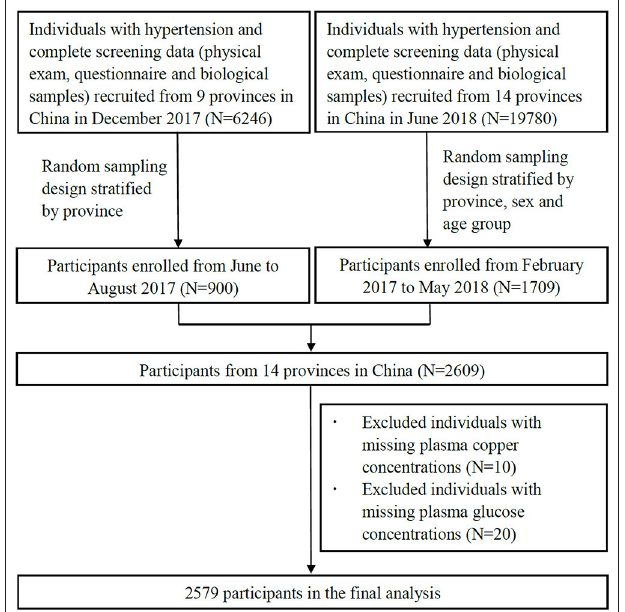
FIGURE 1 | Participant flow chart of the cross-sectional study with 2,579 Chinese adults with hypertension in 14 provinces, China. The nine provinces are Gansu, Liaoning, Beijing, Hebei, Jiangsu, Shanxi, Sichuan, Guangxi and Hunan; the 14 provinces are Gansu, Liaoning, Beijing, Hebei, Jiangsu,